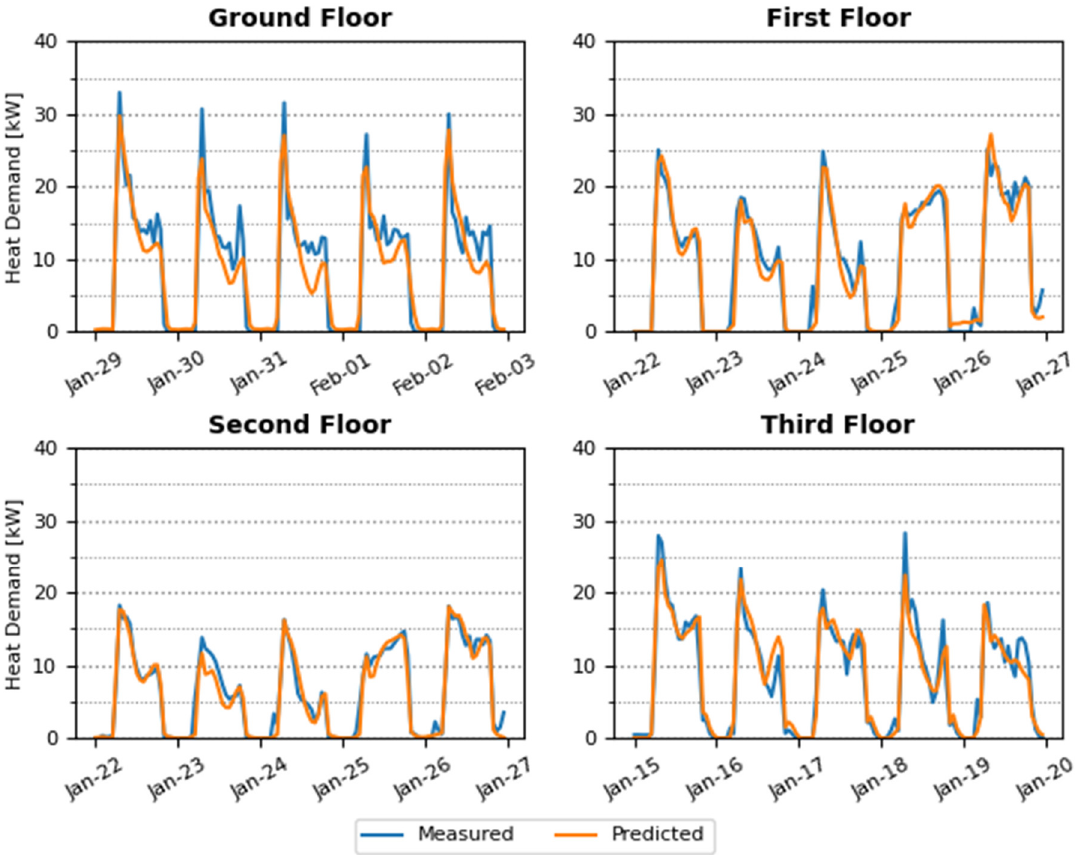
Figure 5. Results of thermal demand predictions on GF ( top left ), 1F ( top right ), 2F ( bottom left ) and 3F ( bottom right ).